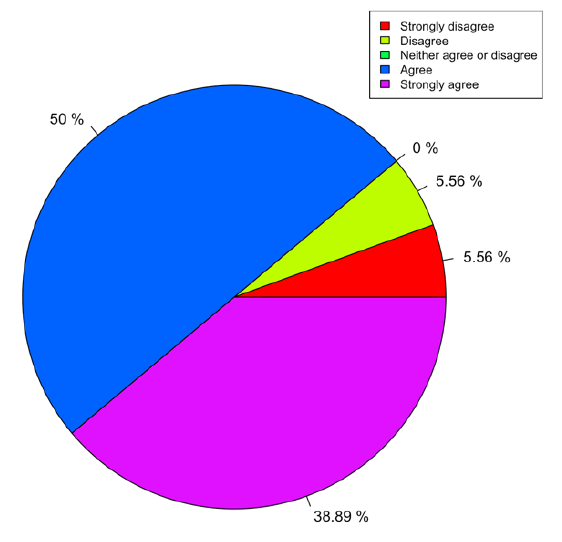
Figure 12. Survey results on students ’ answers to Q16.